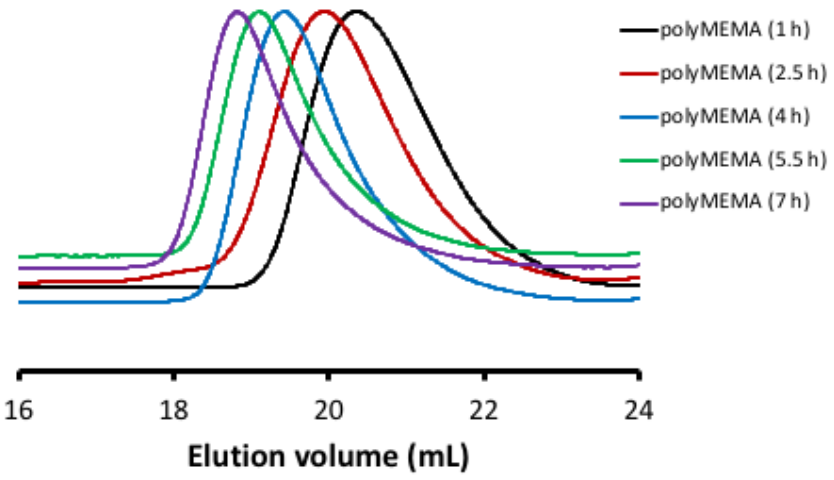
Figure 2. SEC profiles of